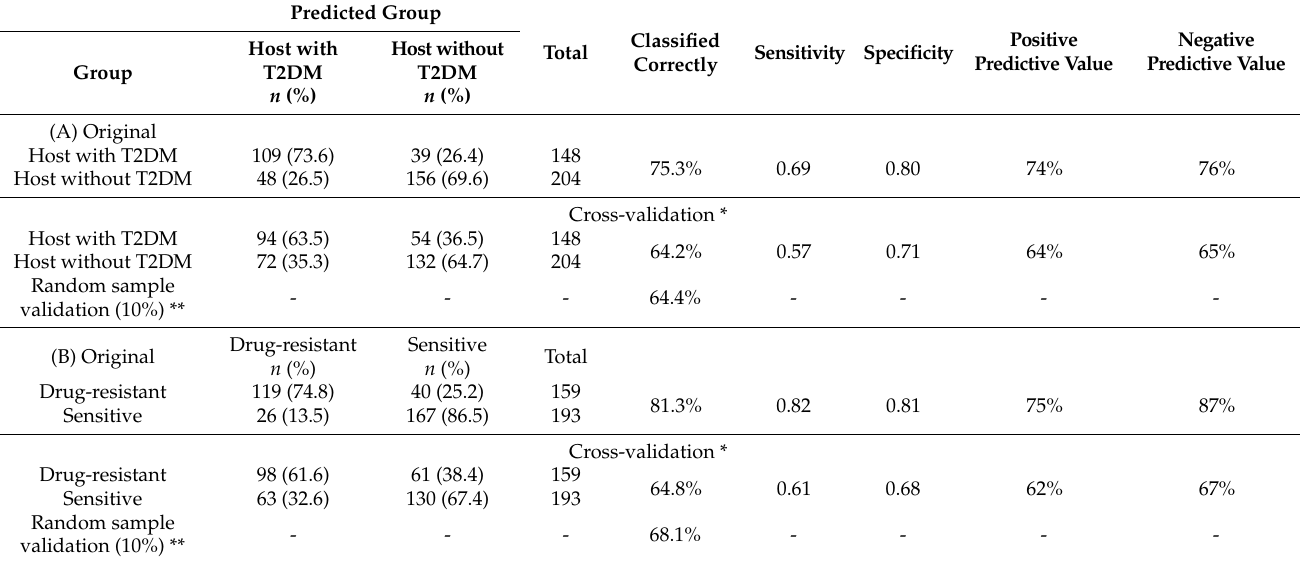
Table 4. Discriminant analysis to predict diversification associated with the presence of T2DM in the host and drug resistance according to SNPs in genes related to DNA damage repair. Predicted Group